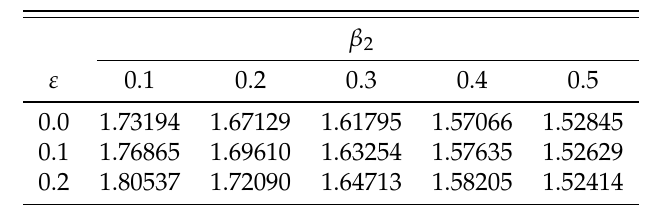
Table 6. Z (Heat transfer coefficient) as a function of β 2 and ε . Here x = 0.1, Q = − 1.2, β 1 = 0.2, Br = 0.5, ϕ = π /4, M = 4, λ 1 =